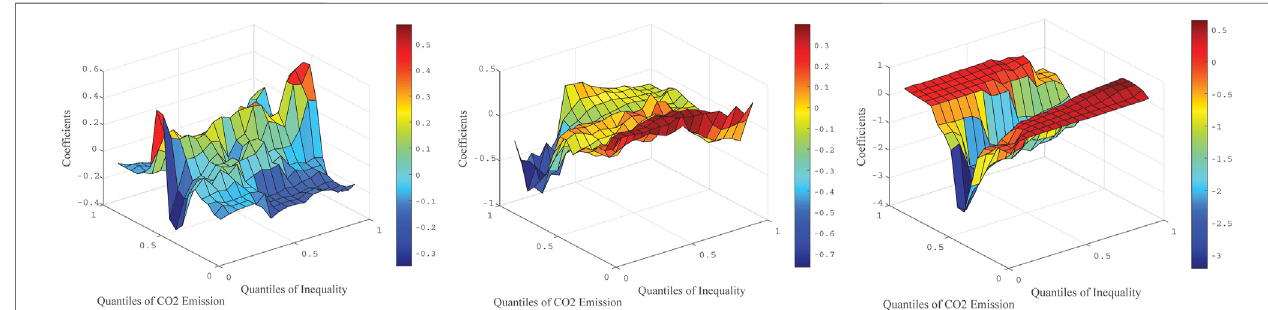
FIGURE 10 | The impact of carbon emission on income inequality in the short, medium and long term (U.S.).